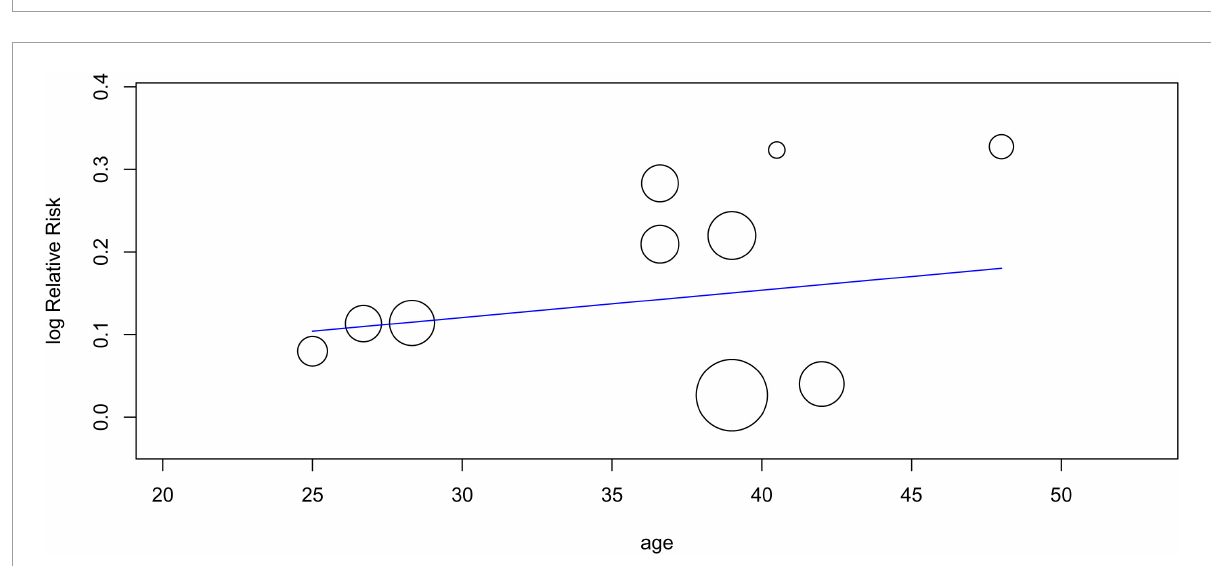
FIGURE6 Meta-regression plot showing the association between patient age and response